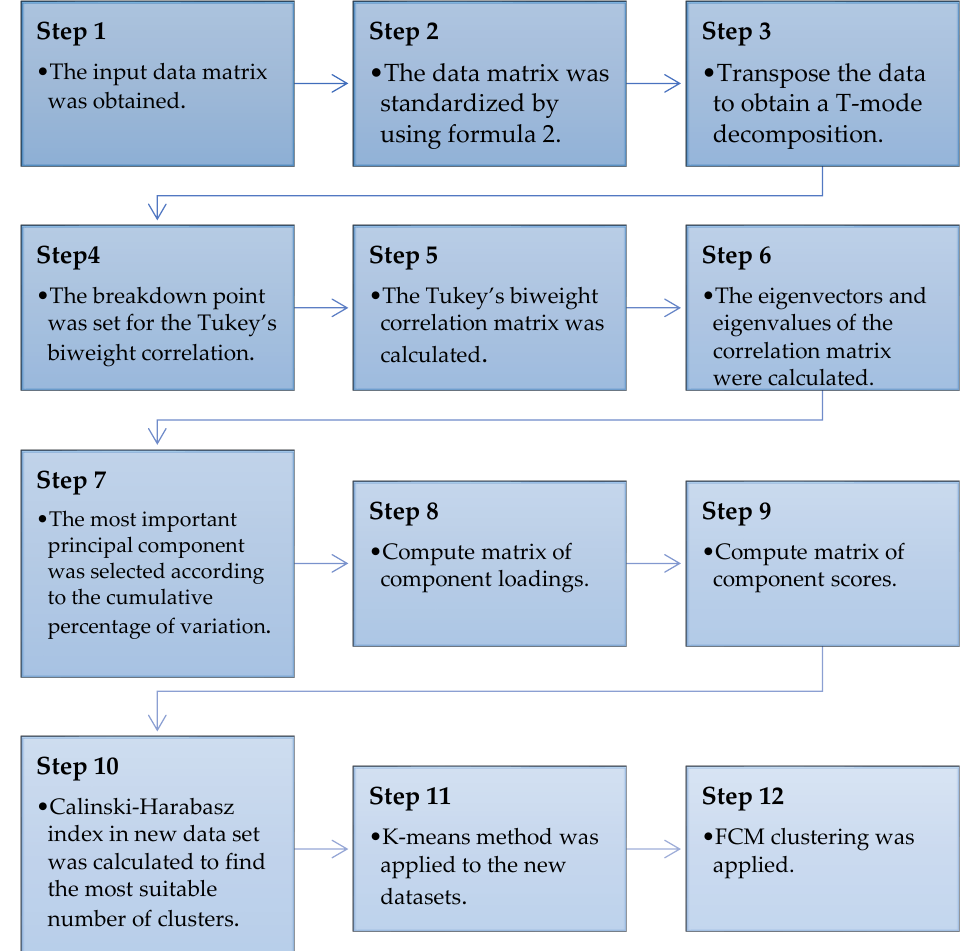
Figure 4. Procedure of RPCA-FCM.